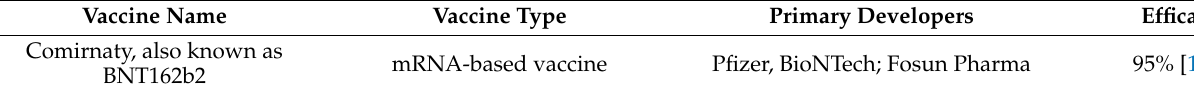
Table 2. Authorised vaccines available for COVID-19 are arranged according to vaccine types in March